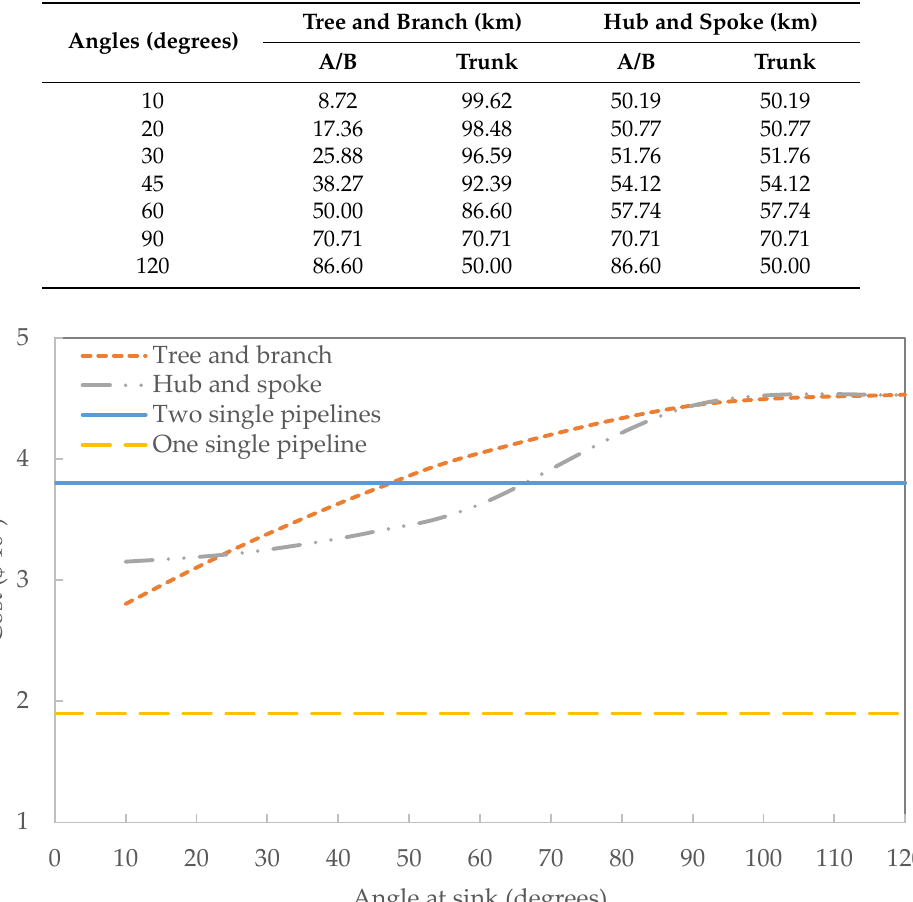
Table 2. Length of pipelines (km).